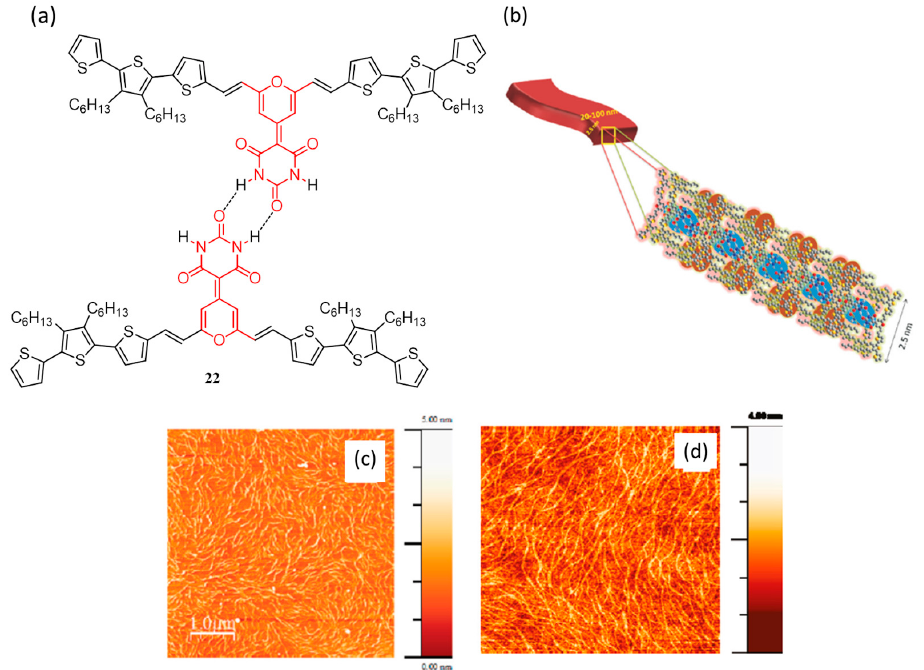
Figure 9. Schematic representation of ( a ) the intermolecular H-bonding between thiophene oligomers ( 22 ) synthesized by Patil et al. [56] and ( b ) the self-assembly of 22 into nanoribbons. AFM topography image of 22 in the ( c ) absence and ( d ) presence of PC 61 BM spin-cast from chlorobenzene solution. Adapted with permission from Ref. [56] Copyright 2011 American Chemical Society.